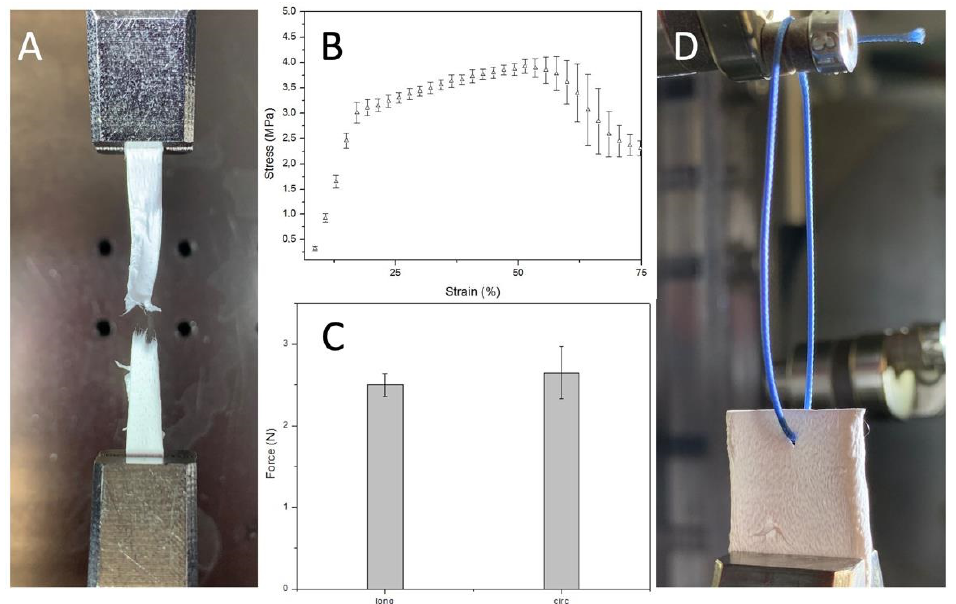
Figure 6. ( A ) sample detail after failure ( B ) Uniaxial stress-strain curve ( n = 3) ( C ) Uniaxial suture retention force ( n = 3) ( D ) Sample details of PBS graft before suture pullout.